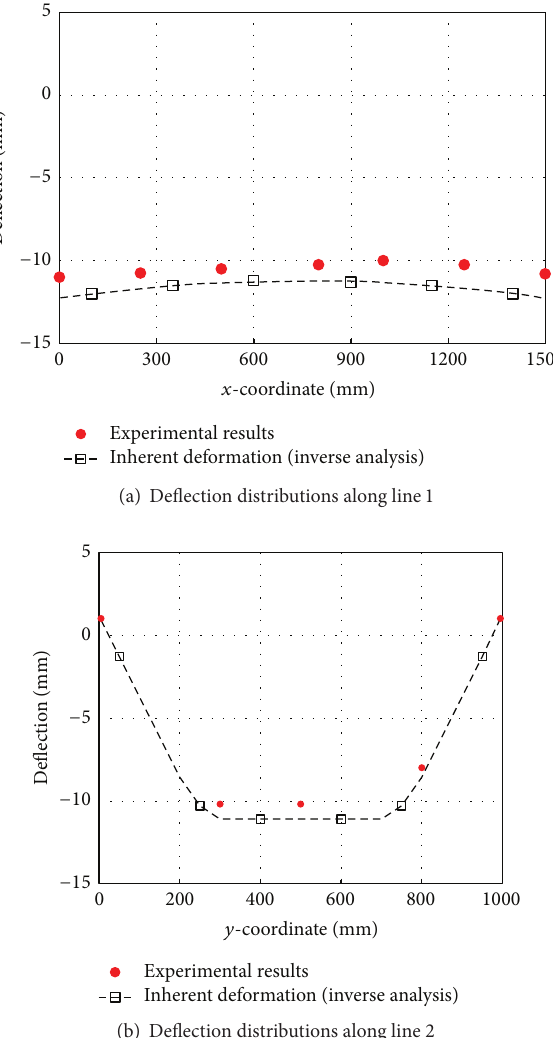
Figure 12: Comparison of deflection between experiments and